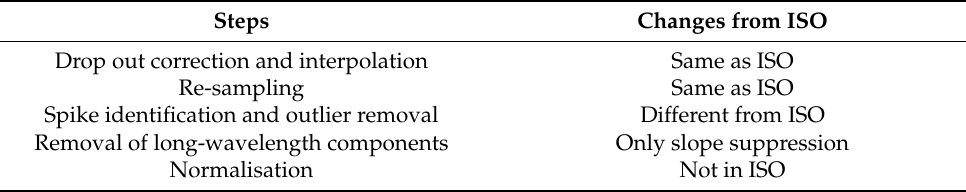
Table 4. Laser workflow.